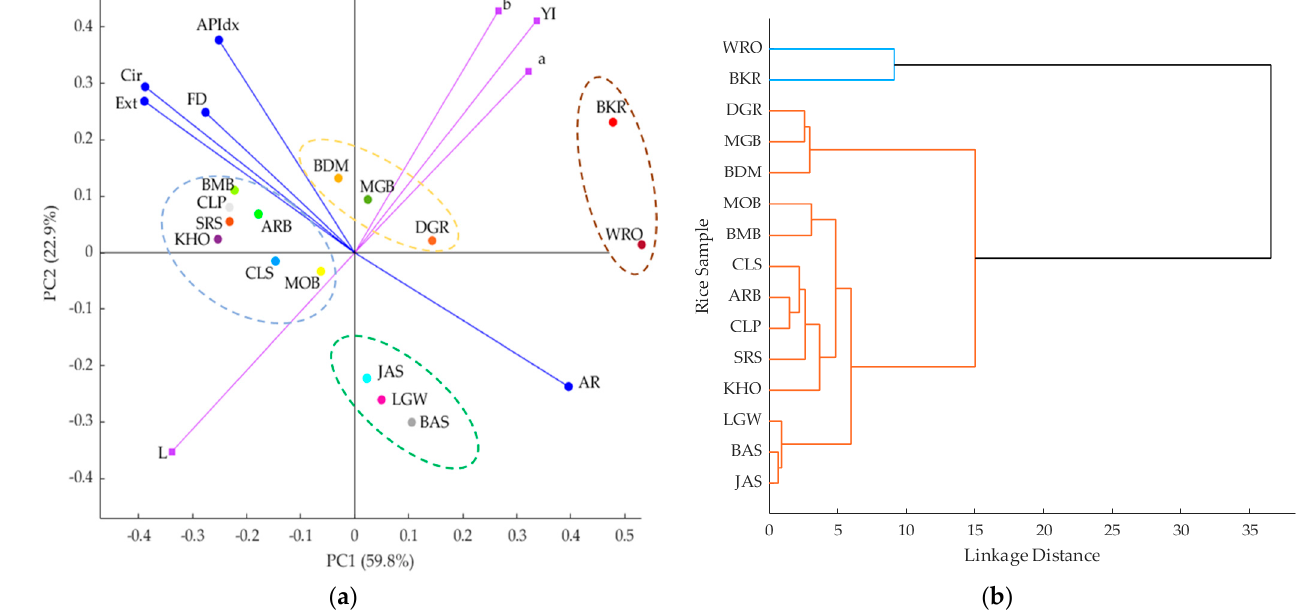
Figure 7. The multivariate data analysis for ( a ) principal component analysis (PCA) biplot for morpho-colorimetric parameters of 17 commercial rice types, where PC1 = principal component one, PC2 = principal component two; and ( b ) cluster analysis of the commercial rice samples based on morpho-colorimetric parameters. The abbreviations for morpho-colorimetric parameters and rice samples are shown in Tables 1 and 2.